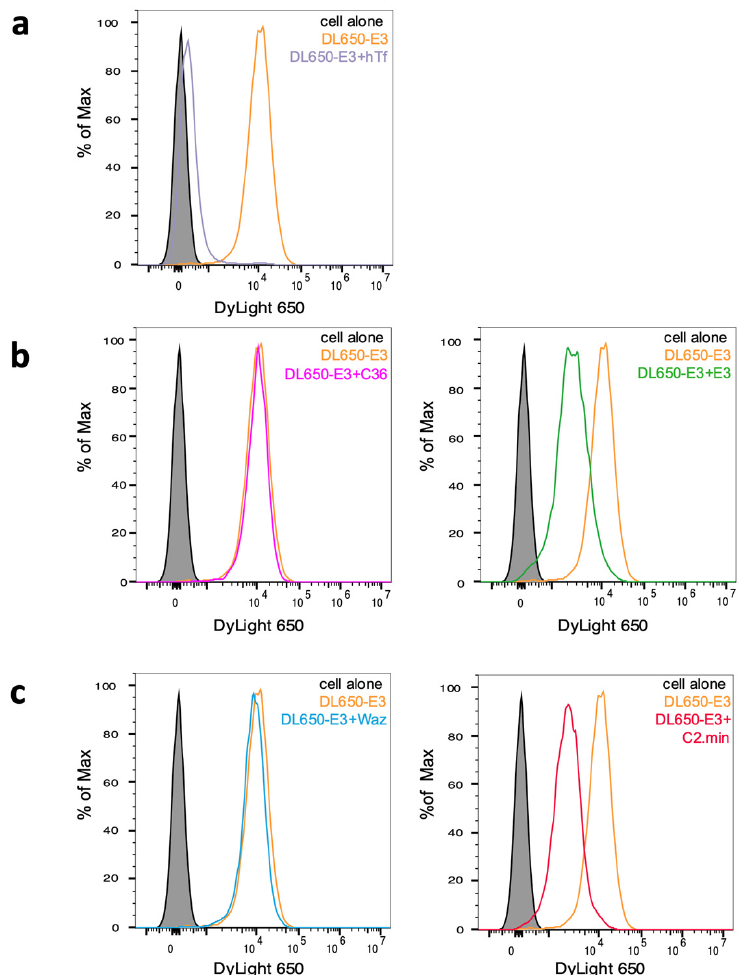
Figure 2. The changes of 200nM DL650-E3 binding signal in competition assays. Competitors were preincubated with 22RV1 cells. ( a ) The binding signals of DL650-E3 after competing with 1mg/mL transferrin is presented here in purple. The non-competed DL650-E3 binding signal is shown in orange. The fluorescence intensity of DL650-E3 was collected after cells were pre-incubated with a 10-fold excessive amount of ( b ) C36, itself, ( c ) Waz, and C2.min, which are shown in magenta, green, blue, and red, respectively.